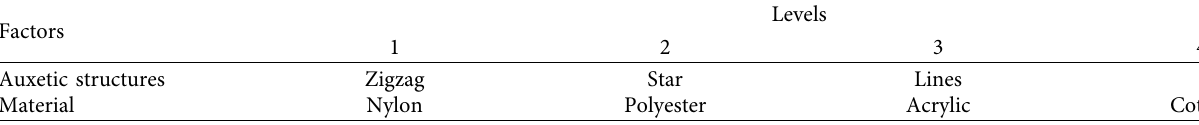
Table 1: Experimental factors and levels of the research.